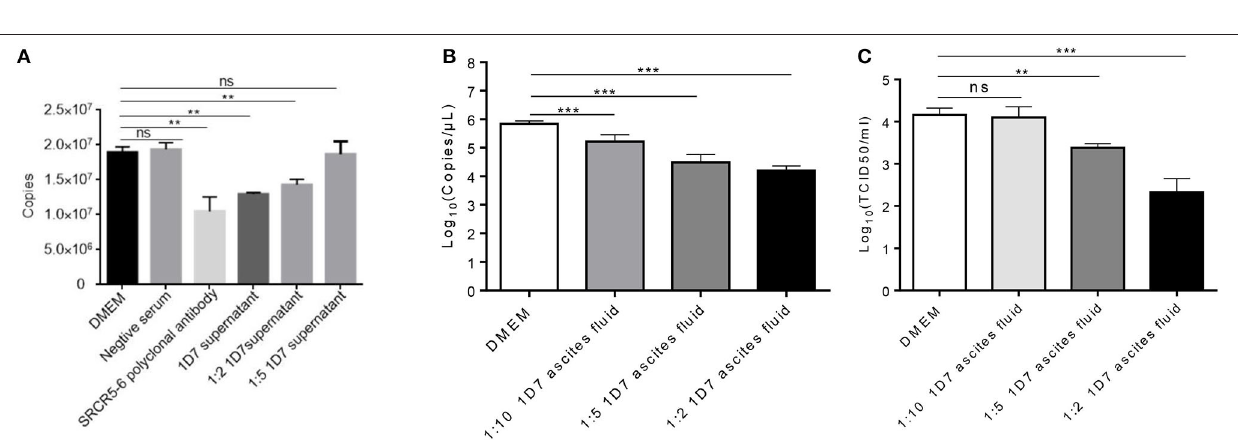
FIGURE 3 | Mapping the epitope of mAb 1D7. (A) A series of truncated SRCR5-6 were constructed to pCold-TF and was successfully expressed in E. coli BL21(DE3) cells. Protein expression was then induced with IPTG. After incubation at 16 ◦ C for 12h, the cells were harvested for SDS-PAGE. Schematic diagram and western blotting results using 1D7 to probe truncated TF-SRCR5-6. (B) A battery of peptides corresponding to amino acids 497–506 were synthesized. Four hundred nano grams peptides were coated to the ELISA plates in order. Indirect ELISA was used to analysis the epitope of 1D7.